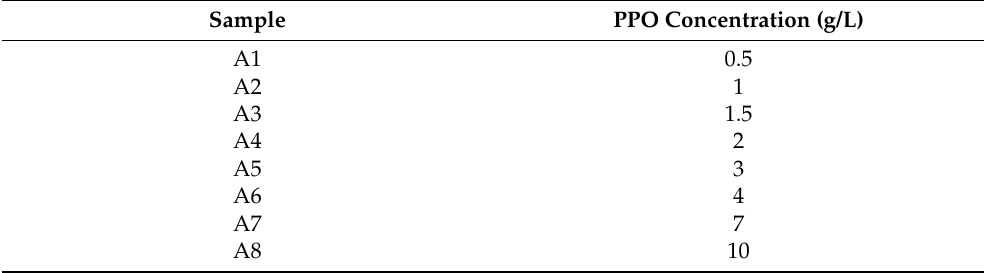
Table 1. LS samples with different PPO concentrations. The concentration of PPO varied from 0.5 g/L to 10 g/L. The bis-MSB was not dissolved in the